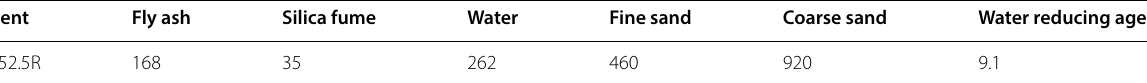
Table 3 Mix proportion of fine-grained concrete (kg/m3).